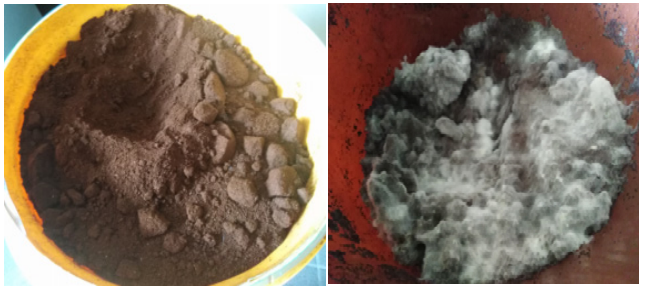
Figure 3. Spent coffee grounds after collect ( left ) and four weeks storage ( right ) in a closed bucket at room temperature.